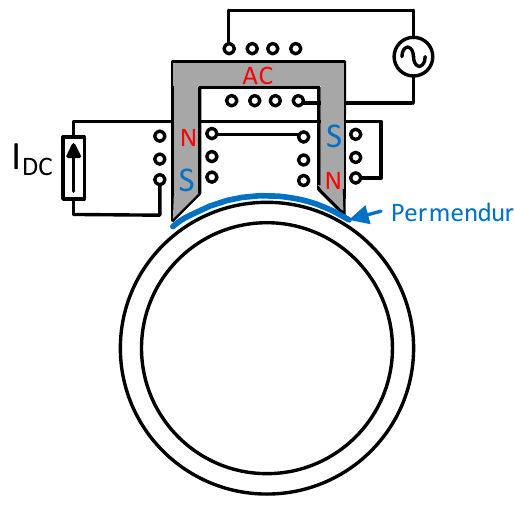
Figure 11. New magnetostrictive transducer.